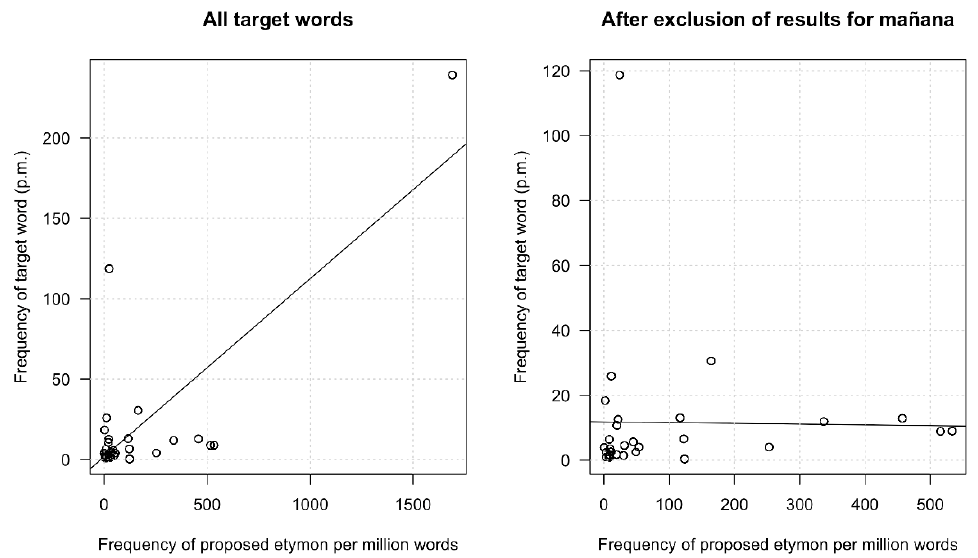
Figure 1. Correlation between the usage frequencies of the target words and the proposed etymons.